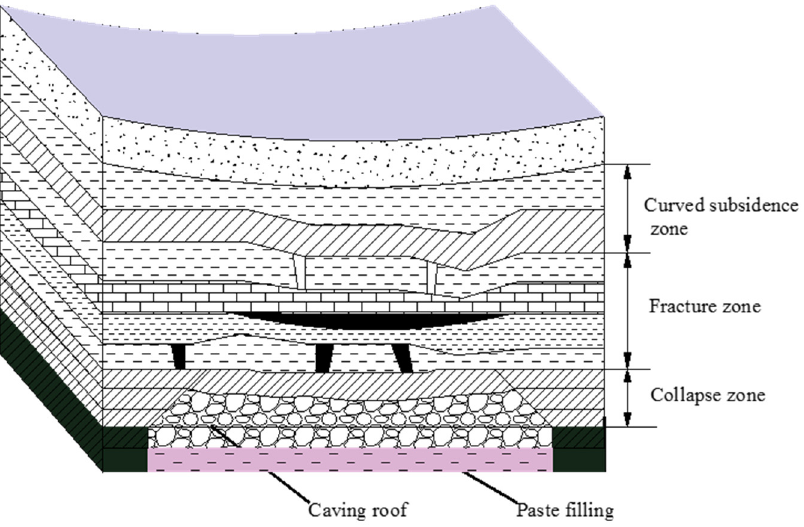
Figure 1. Schematic diagram of PCFM.